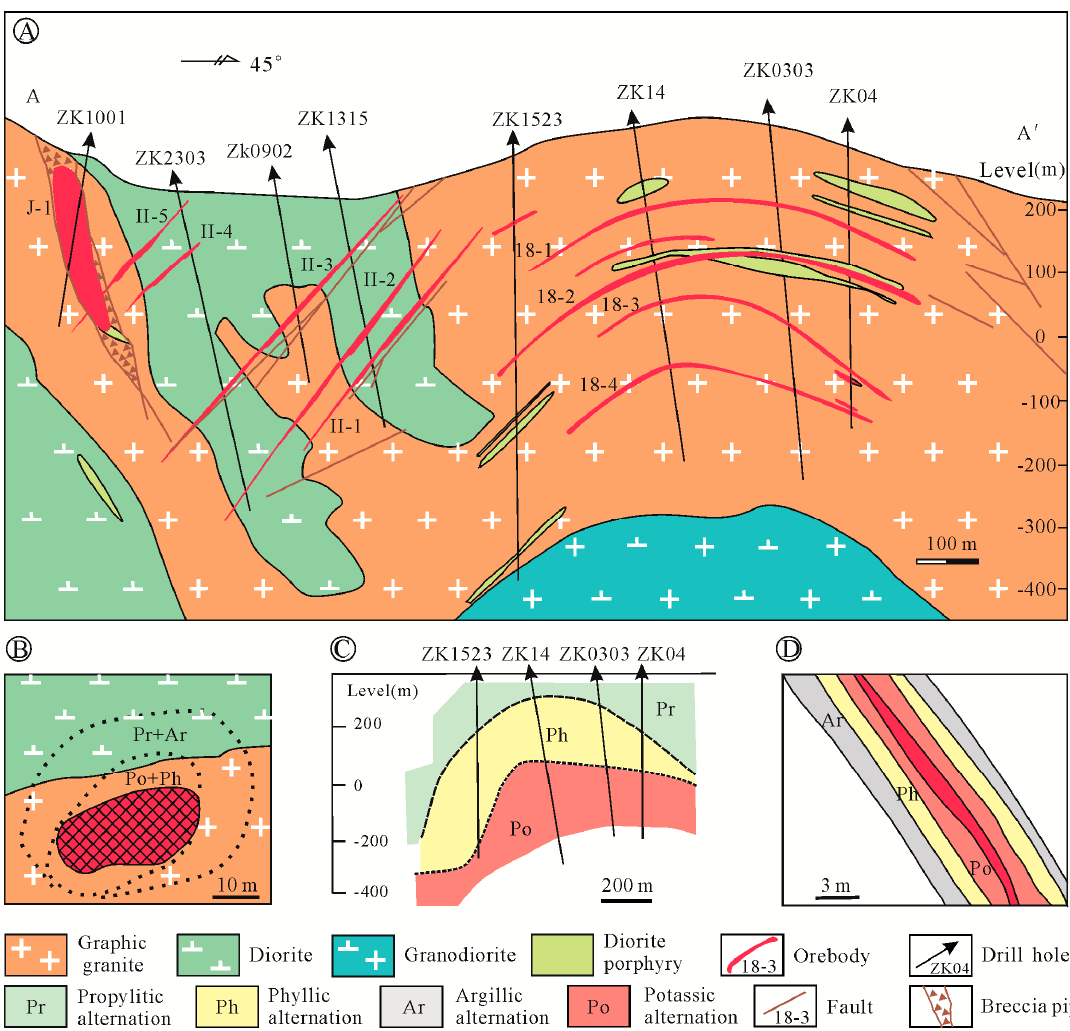
Figure 3. ( A ) Geological sections of the different orebodies. ( B ) Alteration patterns of breccia-hosted orebody [19]. ( C ) Alteration patterns of disseminated orebody [19]. ( D ) Alteration patterns of vein-type orebody [19].